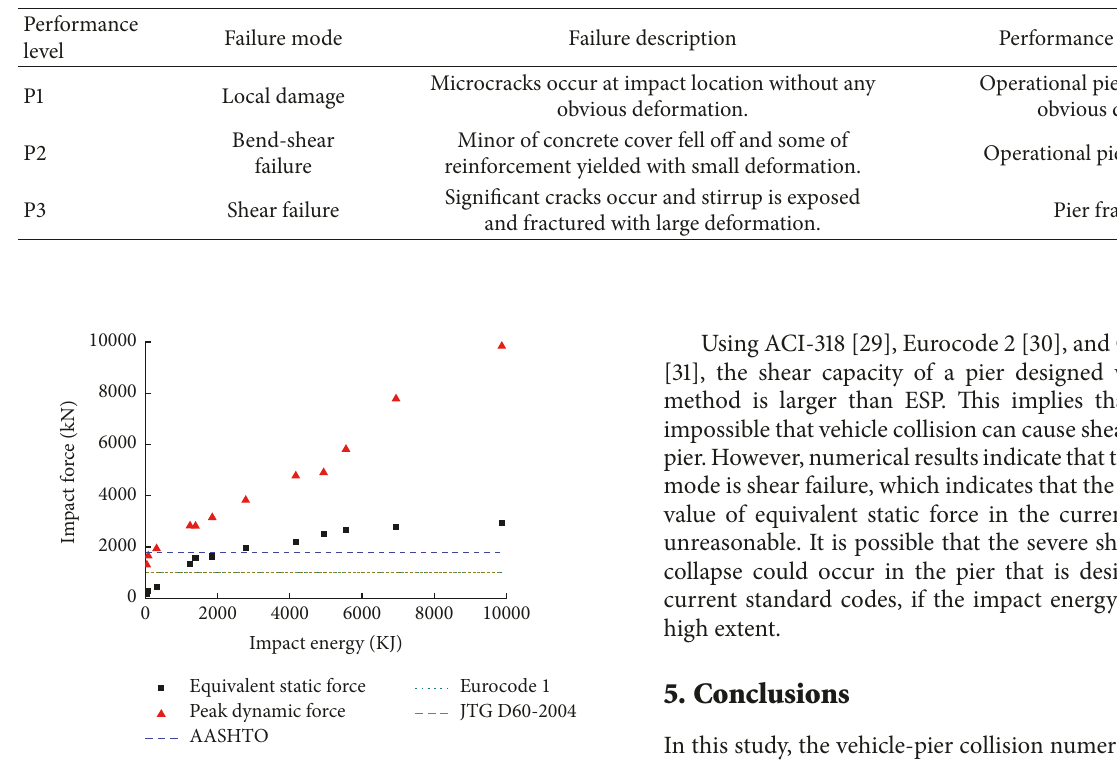
Table 8: Performance level of the impacted piers.